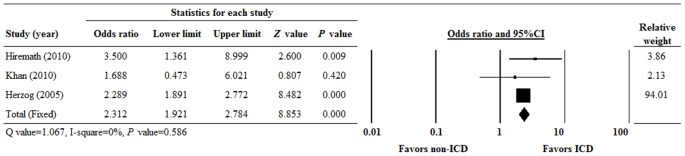
Forest plot of odds ratios (ORs) with 95% confidence intervals (CIs) for 2-year survival of the included studies.P<0.05 indicates a statistically significant difference.